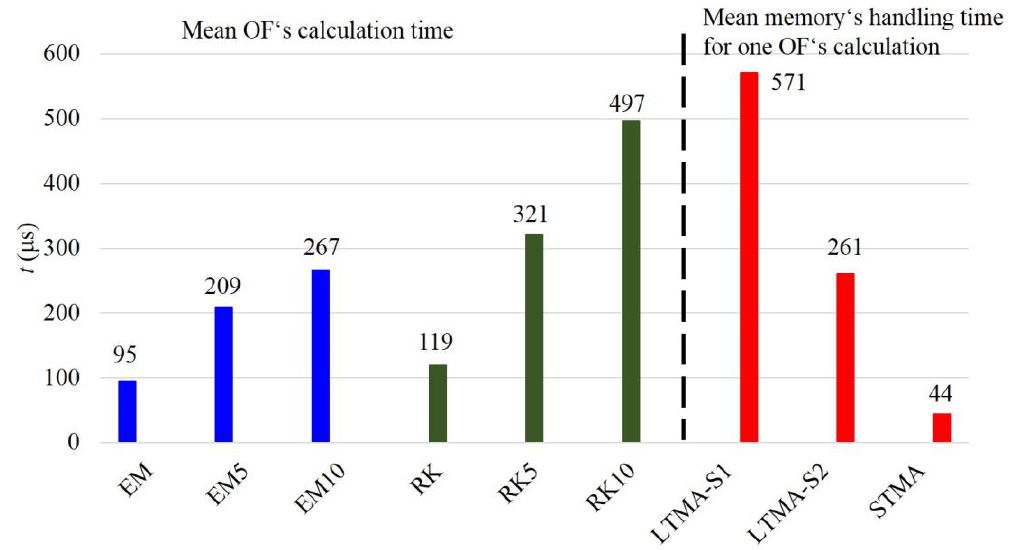
Figure 25. Mean OF calculation times and mean memory handling times for one fitness evaluation.